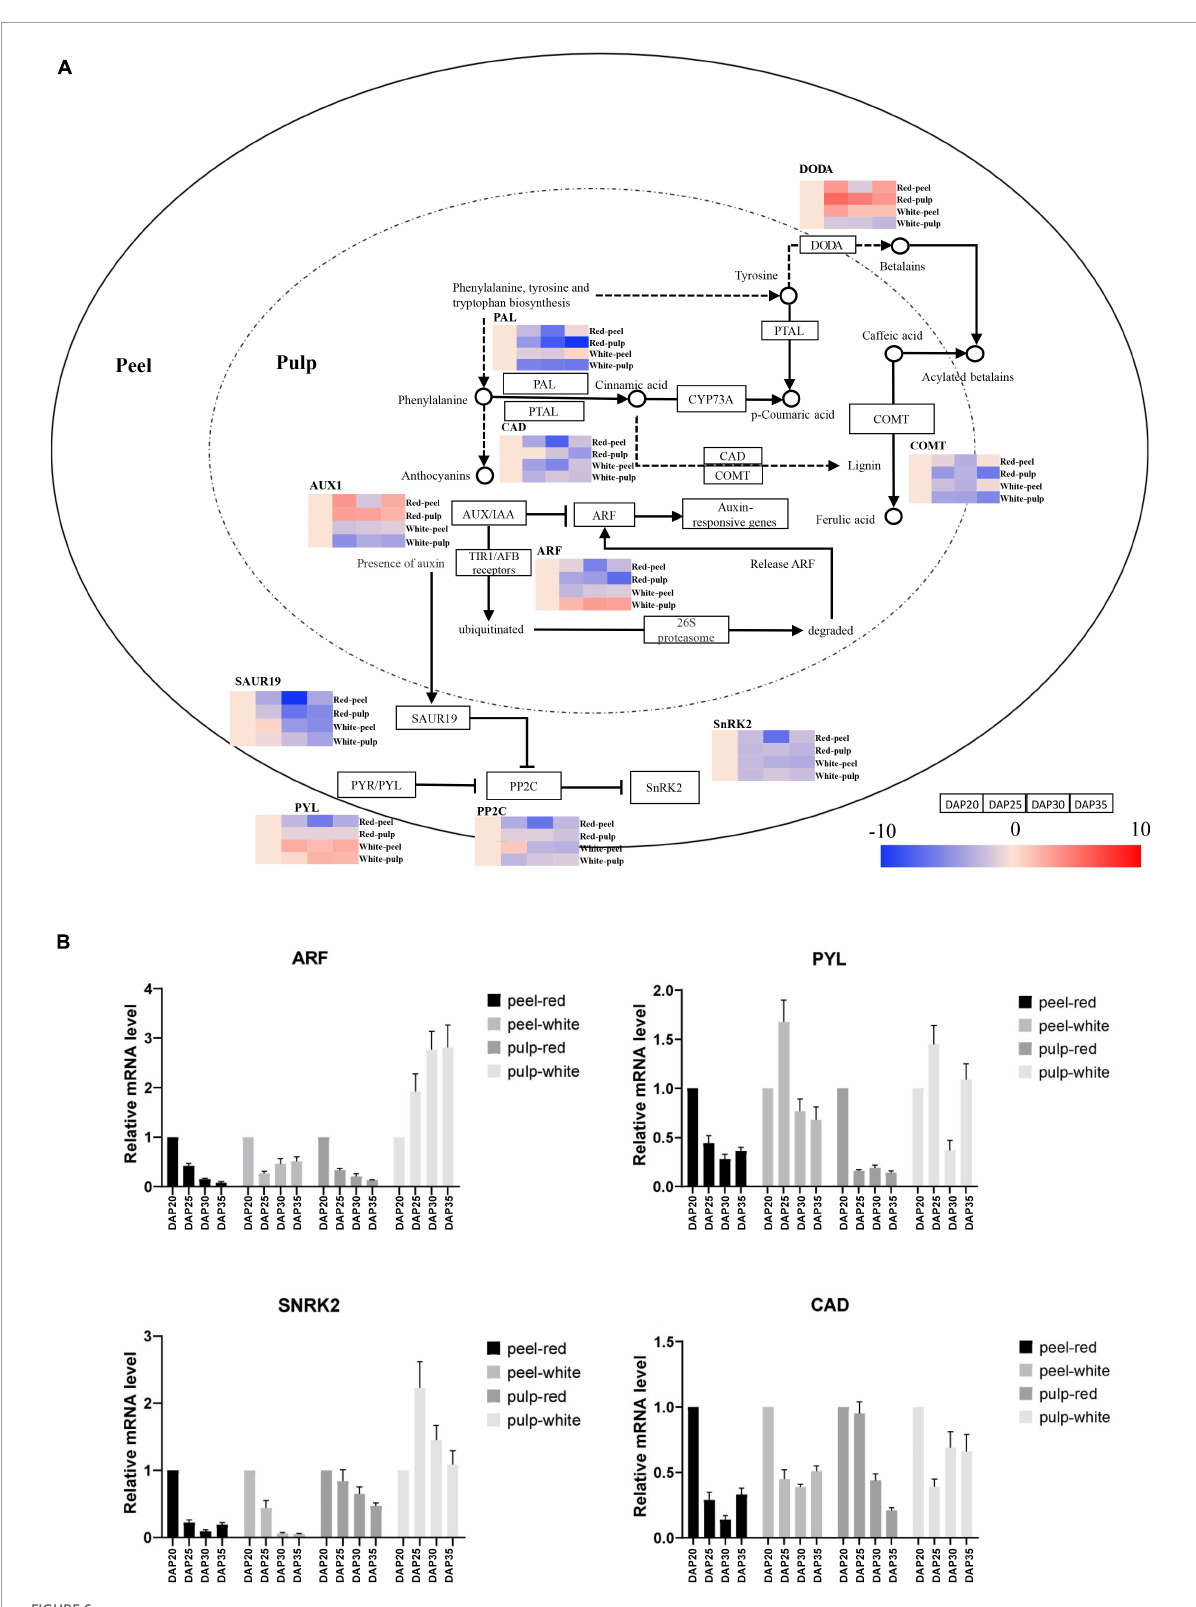
FIGURE6 Temporal gene expression trends in key pathways during fruit ripening. (A) Gene expression alteration trends in plant hormone signal transduction, phenylpropanoid biosynthesis and betalain biosynthesis pathway. (B) Gene expression profiles validated by quantitative real-time